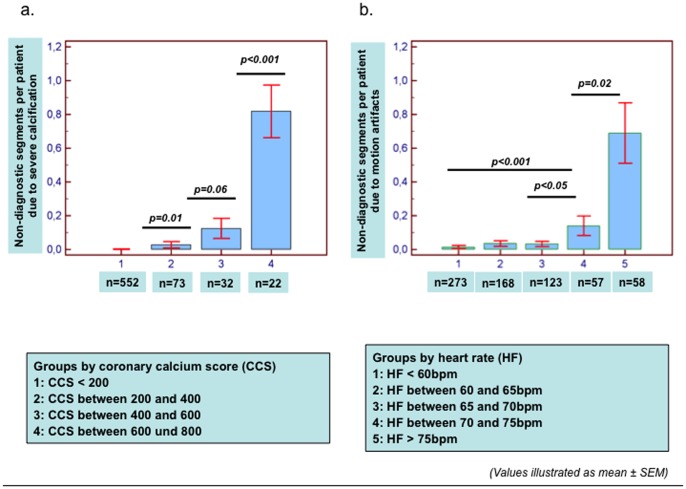

Non-diagnostic segments with ‘control phase’ studies.The number of non-diagnostic segments due to calcification or due to motion artifacts was associated with increasing total CCS (a) and increasing heart rates (b), respectively. Significant differences in terms of non-diagnostic segments due to calcification and motion artifacts were observed especially with CCS>600 (a) and heart rates>75 bpm (b), respectively.